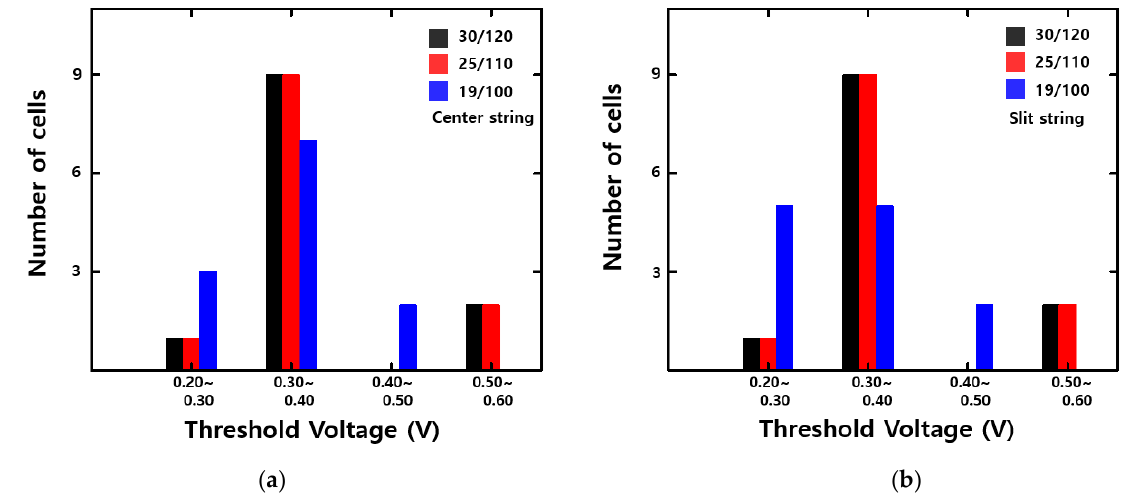
Figure 6. Distribution of initial threshold voltages of cells when the spacer thickness and hole diameter are both scaled on the string located near the ( a ) center and ( b ) common source line.